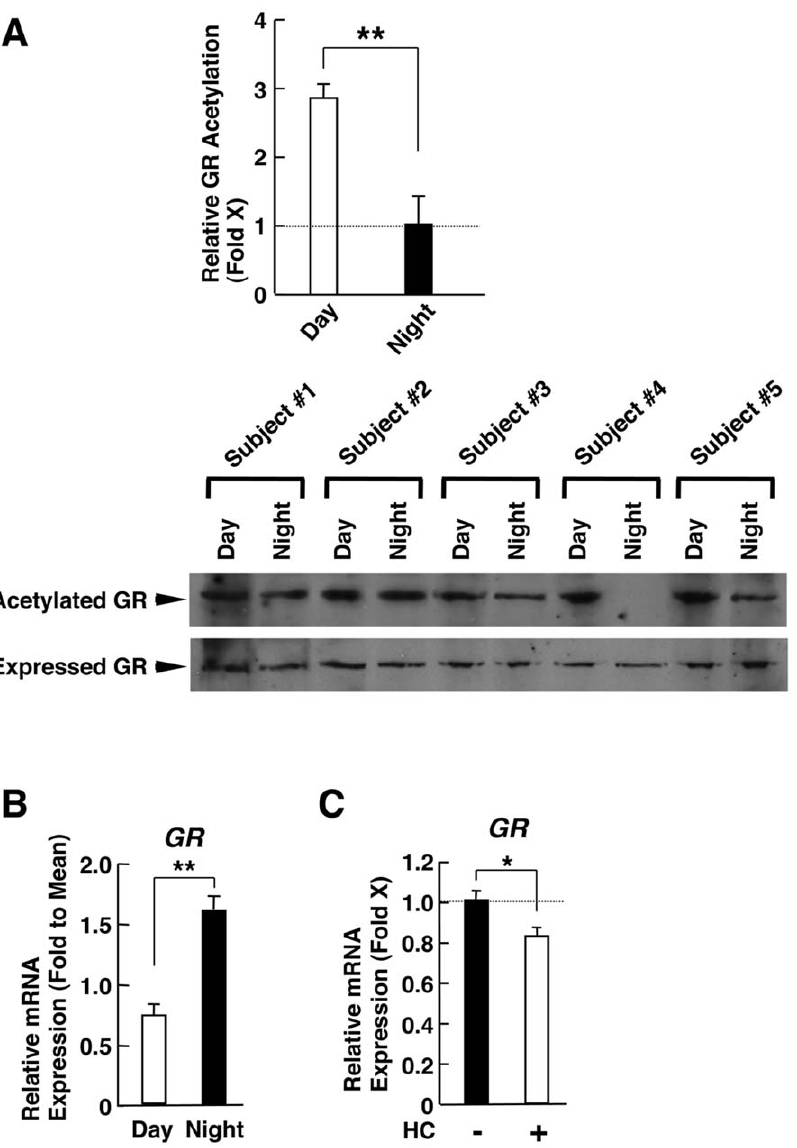
Figure 3. Daily changes of the GR acetylation and its mRNA expression in PBMCs, and response of GR mRNA expression to hydrocortisone in EBV-transformed peripheral lymphocytes. A: Acetylation of GR protein is high in the morning and low in the evening. Acetylation of GR was examined in whole cell lysates obtained at 8 am (Day) and 8 pm (Night) from PBMCs purified from 5 subjects. Band intensity of acetylated GR obtained in 3 independent experiments was corrected for that of total precipitated GR, and relative GR acetylation was calculated as the mean value of all subjects’ measurements corrected values at Night as ‘‘1’’. Bars in the top panel represent mean 6 S.E. values of relative GR acetylation, while representative Western blot images are shown in the bottom panel. **: P , 0.01, compared to conditions indicated (n=5, m=15). B and C: Daily change of the GR mRNA expression in PBMCs ( B ) and its response to hydrocortisone in EBV-transformed peripheral lymphocytes ( C ). Relative GR mRNA expression at 8 am (Day) and at 8 pm (Night) in PBMCs ( B ) and the effect of hydrocortisone (HC) on GR mRNA expression in EBV- transformed peripheral lymphocytes ( C ) are shown. EBV-transformed peripheral lymphocytes were incubated with 5 6 10 2 7 M of hydrocortisone (HC) for 5 hours. The measurements were performed in duplicate and in triplicate for panel B and C, respectively. Bars represent mean 6 S.E. values of relative GR mRNA expression ( B ) or hydrocortisone (HC)-induced fold GR mRNA expression ( C ). *: P , 0.05, **: P , 0.01, compared to the conditions indicated ( B : n=10, m=20, C :